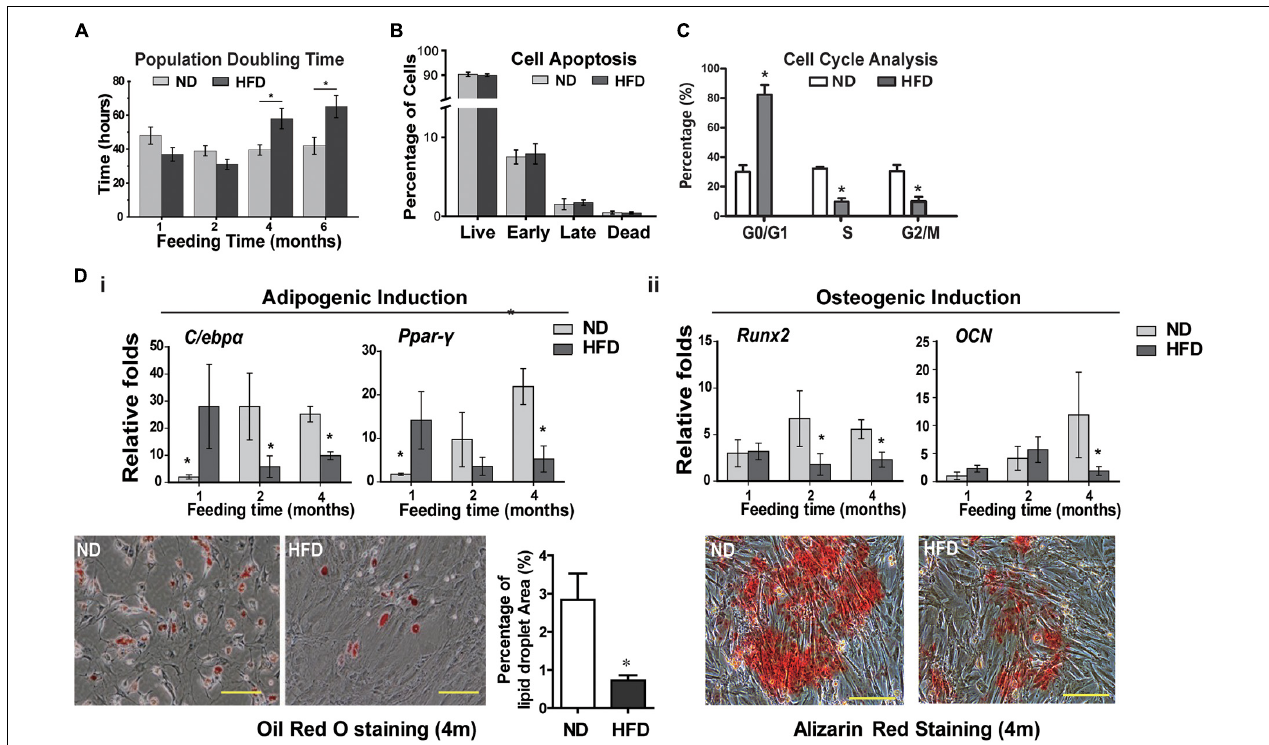
FIGURE 2 | HFD feeding affects the BMSCs functions in rats (A) BMSCs proliferation analysis by measurement of population doubling time. (B) Cell apoptosis analysis. (C) Cell cycle analysis of rats BMSCs. (D) Adipogenic (i) and osteogenic (ii) induction of BMSCs. Expression of adipogenic markers ( C/ebp α and Ppar- γ ) and osteogenic markers ( Runx2 and OCN ) in BMSCs was quantified with real-time PCR. Lipid droplets were visualized using Oil red O staining and the percentage of red-stained lipid droplets area were quantified by Image J. The mineralized nodules in the BMSC culture were detected using alizarin red staining. Data are represented as means ± SEM ( n = 3), Two-tailed Student’s t -test were used to compare two groups of means, * p < 0.05.